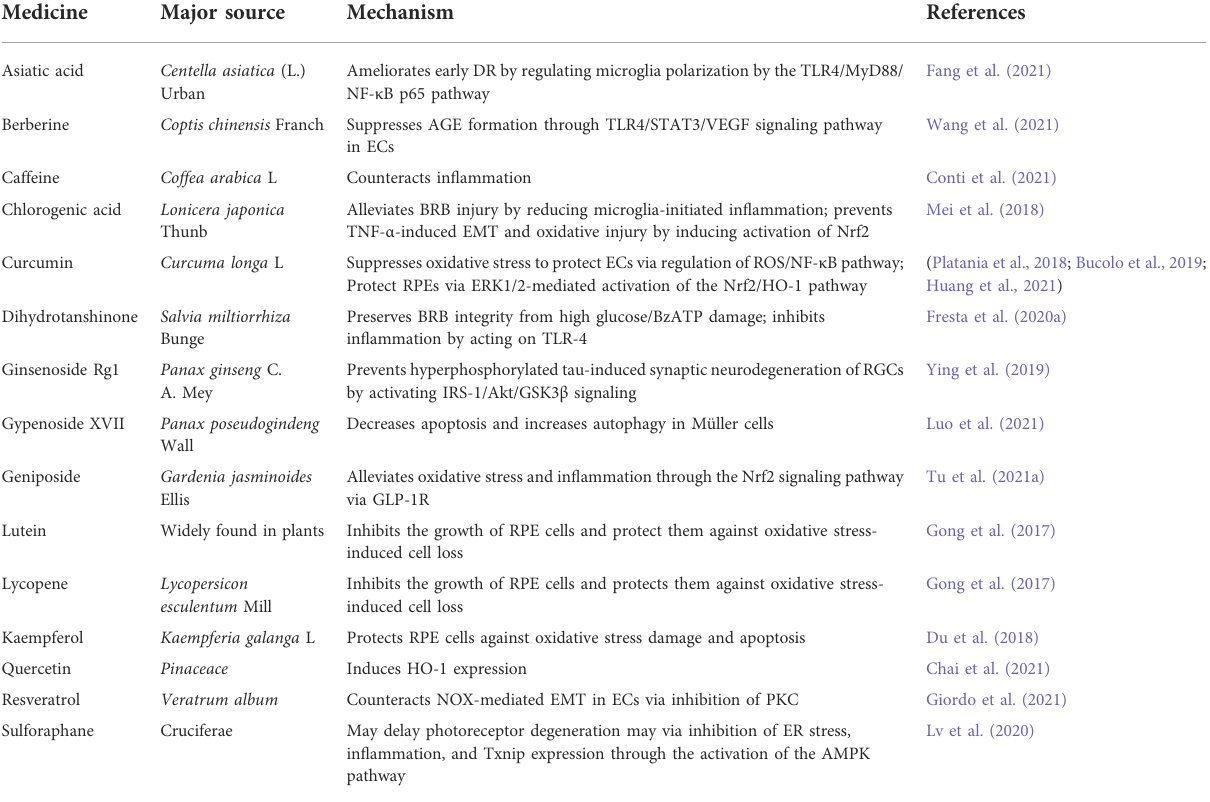
TABLE 6 Natural